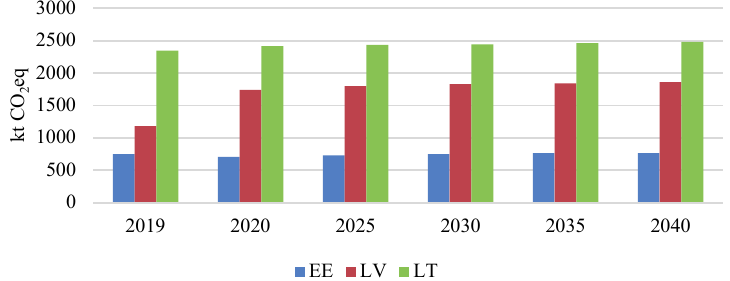
Fig. 4. GHG emissions (historical and projected) from agricultural soils [13]–[18]. T ABLE 1. K EY P OLICIES AND M EASURES U SED IN THE A GRICULTURAL S ECTOR IN B ALTIC